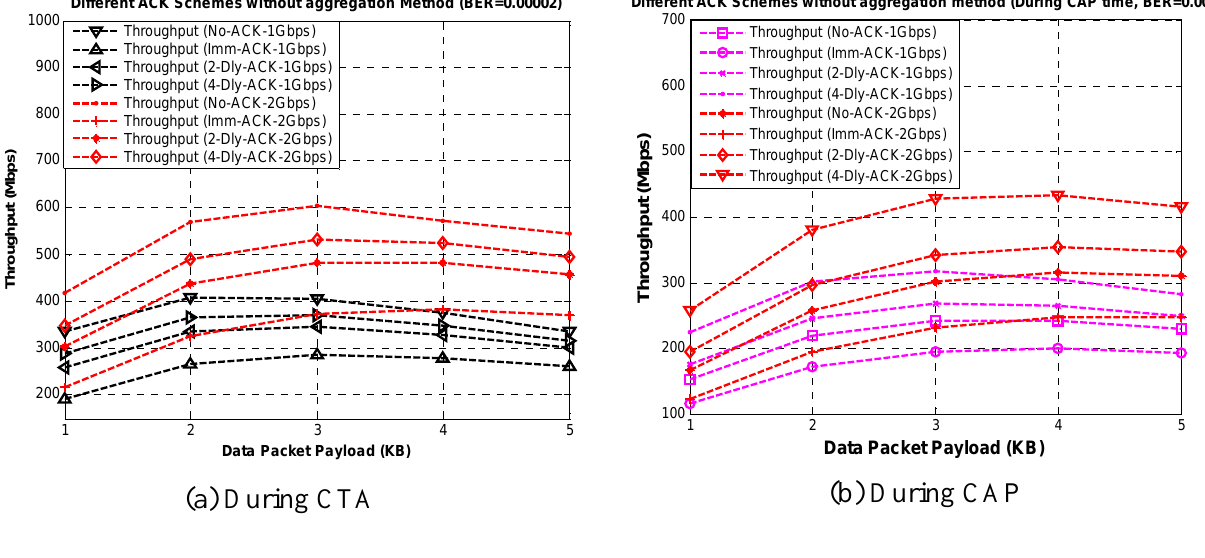
Figure 12. Throughput versus payload size with different ACK policies with aggregation during CTA and